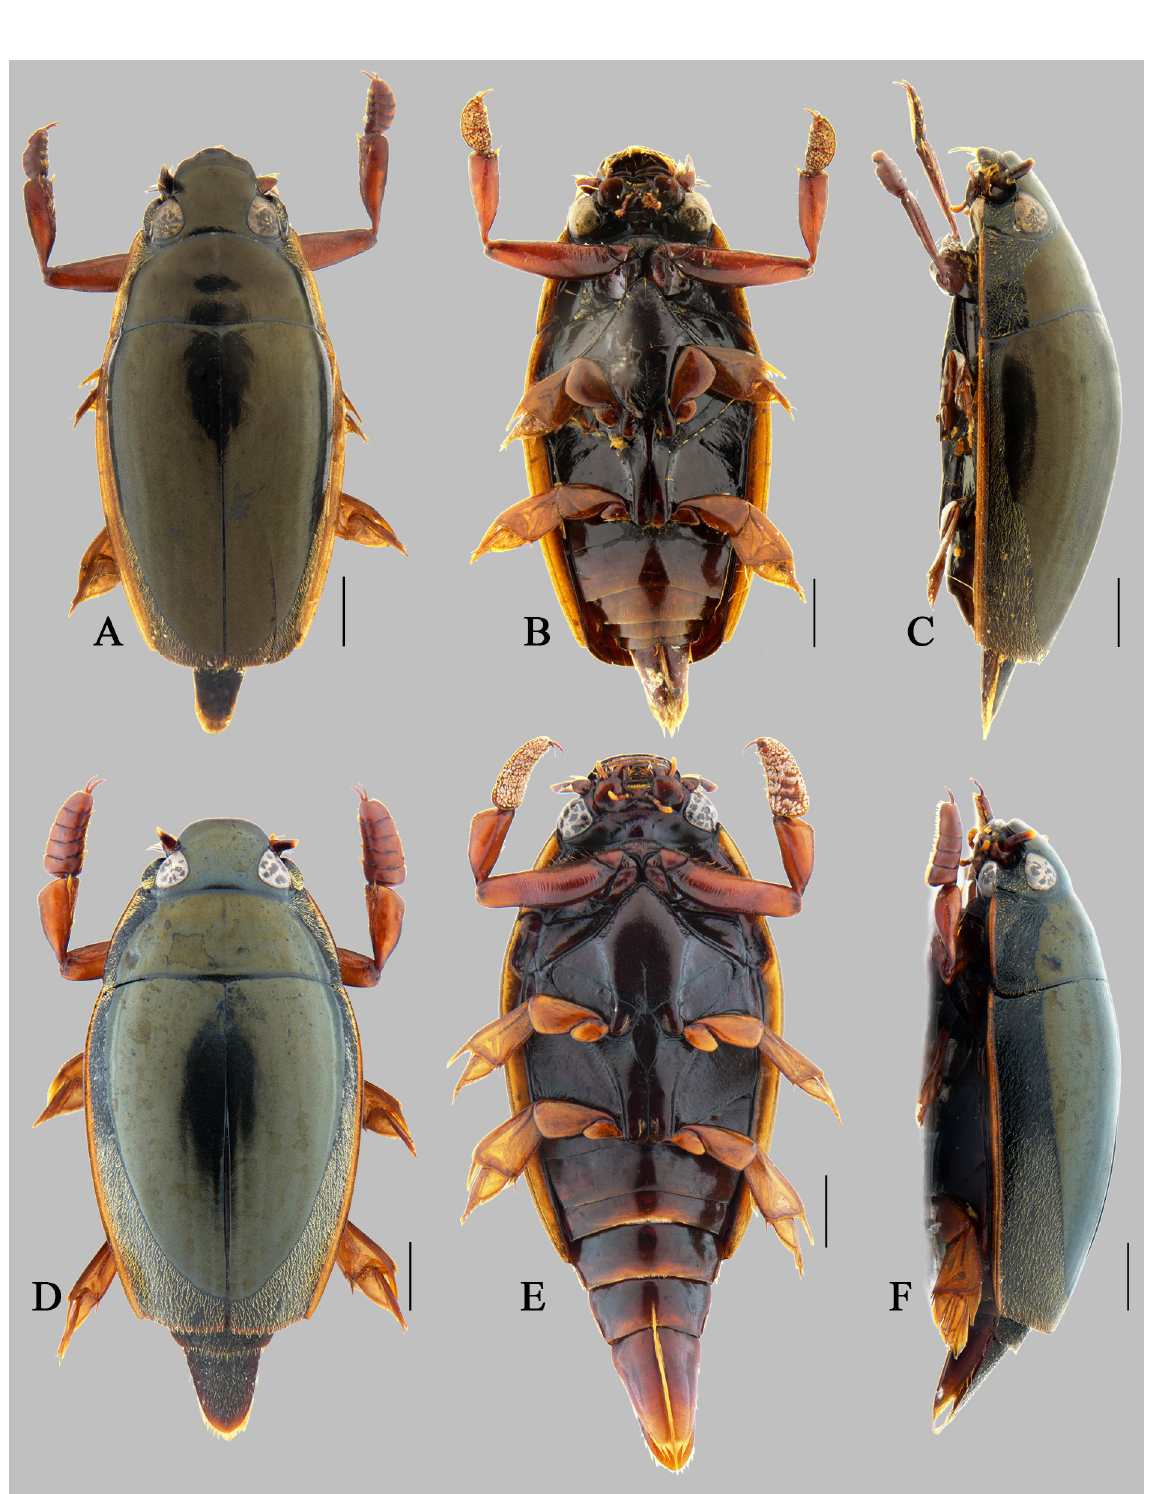
Fig. 1. Habitus. A–C . Patrus hainanensis sp. nov., ♂, paratype (SYSU). D–F . Patrus jiangxiensis . sp. nov., ♂, paratypes (SYSU). A . Dorsal view. B . Ventral view. C . Lateral view. D . Dorsal view. E . Ventral view. F . Lateral view. Scale bars = 1